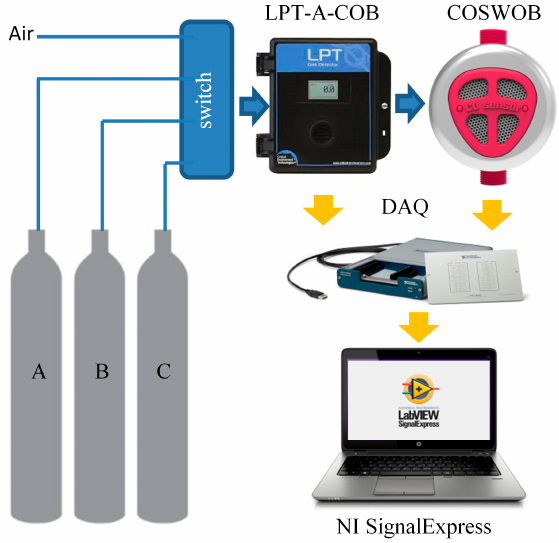
Figure 6. Schematic diagram of a gas sensor calibration system for the COSWOB.